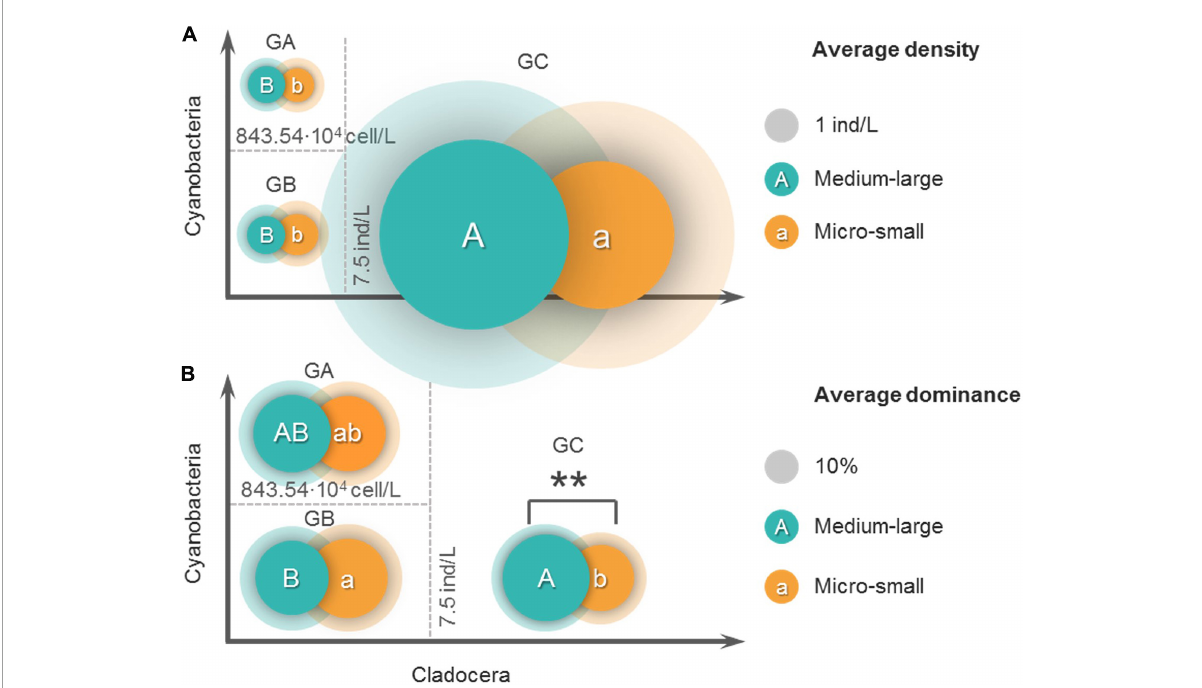
FIGURE6 Comparisons of the average density (A) and average dominance (B) of the two sizes of cladocera in the three groups. Before grouping, the samples with zero cladocera density in the original samples were eliminated. All samples are divided into three groups based on the threshold value. GA: cladocera density < 7.5 ind/L (cladocera density corresponding to the breakpoint position of piecewise regression), and cyanobacteria density > 843.54 10 4 cell/L (cyanobacteria density corresponding to the breakpoint position of piecewise regression). GB: cladocera density < 7.5 ind/L and cyanobacteria density < 843.54 10 4 cell/L. GC: cladocera density > 7.5 ind/L. The capital letters A and B in the circles represent the results of the LSD post hoc test for the comparison among the groups of medium-large cladocera, and the lowercase letters a and b in the circles represent the LSD post hoc test results for the comparison among the groups of micro-small cladocera. The overlapping of two circles indicates that a comparison of the inner groups was carried out, ** indicates that the result of the comparison of the inner groups is extremely significant ( P < 0.01), and those without ** indicate that the differences in the inner groups are not significant ( P > 0.05). The opaque circles represent the average values, and the transparent rings represent the standard deviations. The areas of the circles and rings represent the averages and standard deviations, respectively.